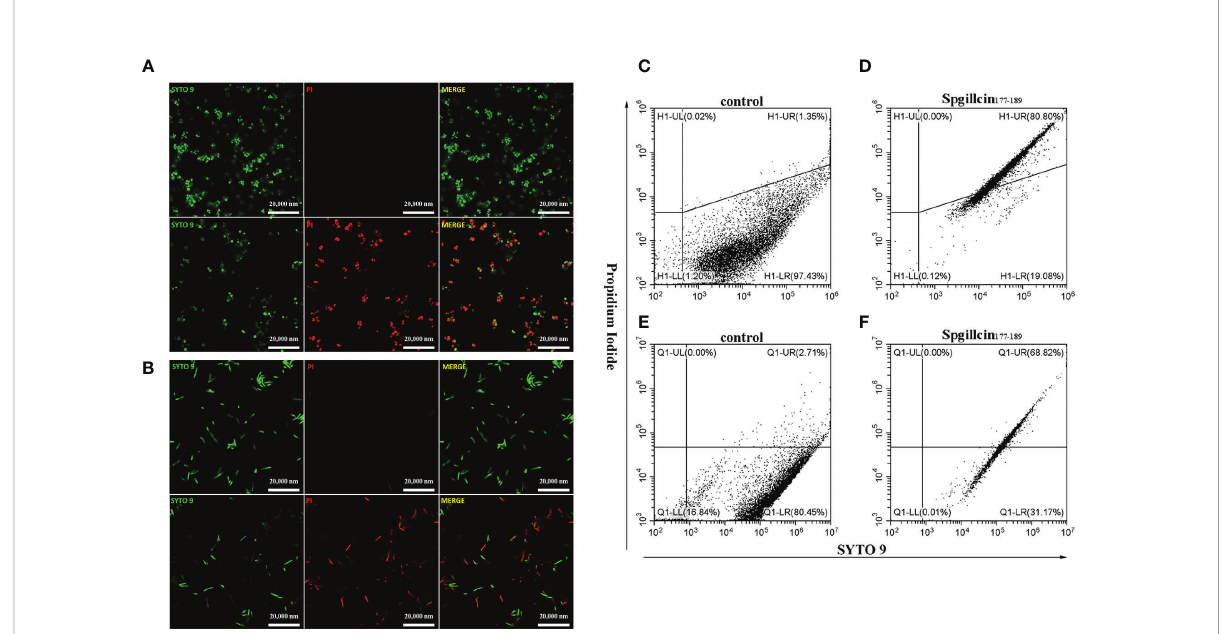
FIGURE 8 Effect of Spgillcin 177 – 189 on the membrane permeability of S. aureus and P. aeruginosa . (A) S. aureus cells were resuspended in culture medium and treated with NaPB (control) or Spgillcin 177 – 189 (1× minimum inhibitory concentration). Fluorescent images of stained bacteria were obtained using confocal scanning microcopy. The upper row was the control group, and the lower row was the Spgillcin 177 – 189 -treated group; scale bars, 20,000 nM. (B) P. aeruginosa cells were suspended in culture medium and treated with NaPB (control) or Spgillcin 177 – 189 (1× minimum inhibitory concentration). Fluorescent images of stained bacteria were obtained using confocal scanning microcopy. The upper row was the control group, and the lower row was the Spgillcin 177 – 189 -treated group; scale bars, 20,000 nM. The membrane permeability of S. aureus exposed to NaPB (C) or Spgillcin 177 – 189 (D) was examined by fl ow cytometry. The membrane permeability of P. aeruginosa exposed to NaPB (E) or Spgillcin